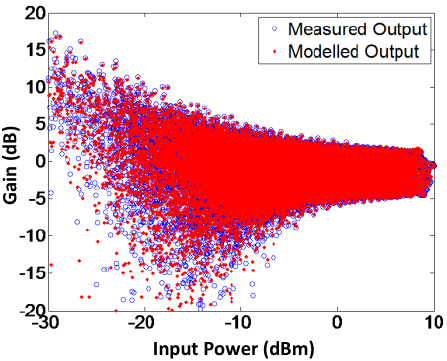
Figure 9. AM-AM characteristics of modeled and measured output signals for the branch-by-branch digital combining architecture. The modeled gain is capable of imitating the actual gain of the transmitter.